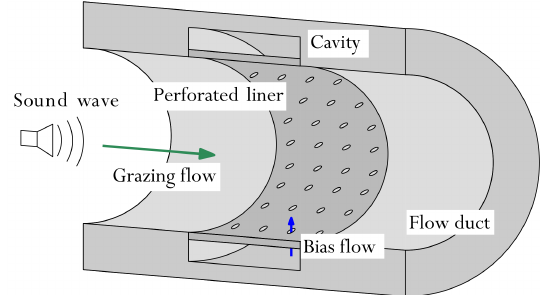
Figure 1. Sketch of a perforated bias flow liner with a cavity be- hind, installed in a flow